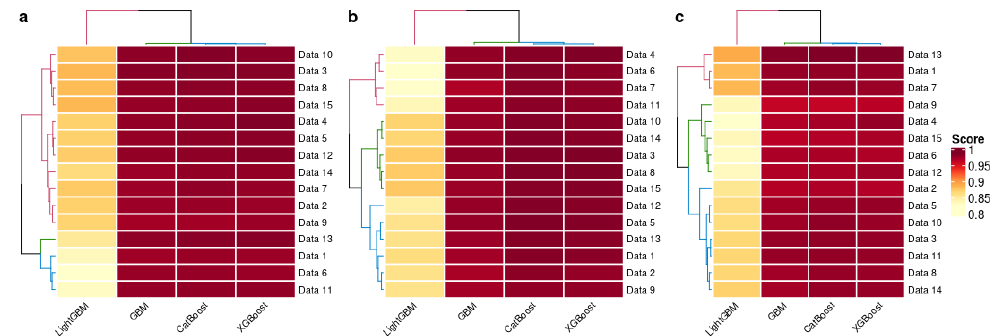
Figure 3. Hierarchical clusters (shown in three distinct colors) of algorithms and imbalanced data sets in terms of ( a ) MCC, ( b ) AUC, and ( c ) F1 metrics. The color in each cell represents the corresponding performance value (light yellow: low; dark red: high).